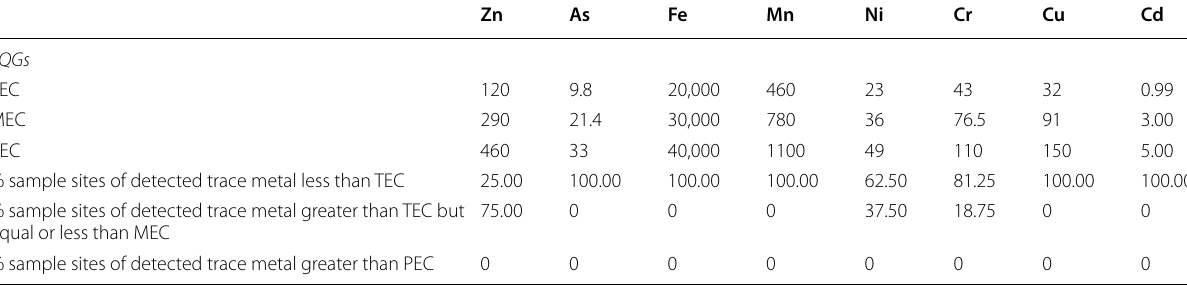
Details of detected trace metals value in each sample site are mentioned in Table 6 in the results section